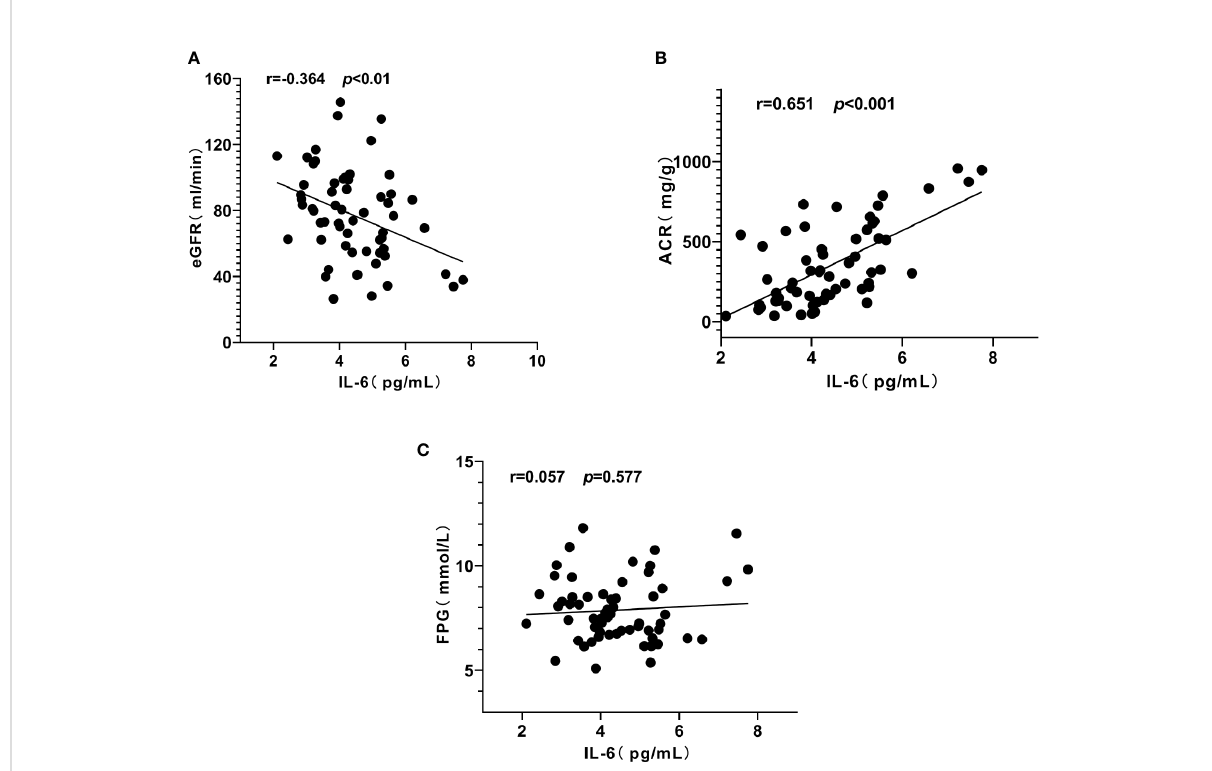
FIGURE 4 Correlation between interleukin-6 (IL-6), urinary albumin/creatinine ratio (ACR) and estimated glomerular fi ltration rat (eGFR) in patients with diabetic kidney disease (DKD). (A) IL-6 was negatively correlated with eGFR. (B) IL-6 was positively correlated with ACR. (C) IL-6 had no signi fi cant correlation with fasting plasma glucose (FPG).